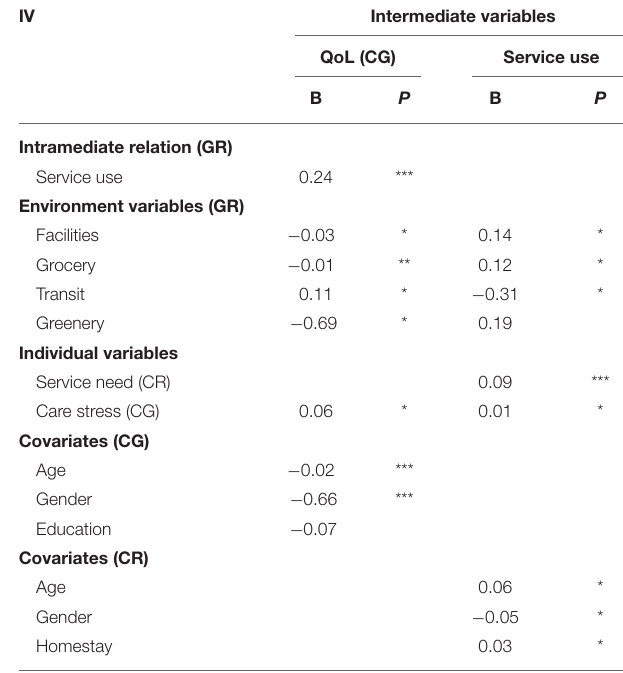
TABLE 3 | Path analysis—function of intermediate variables.